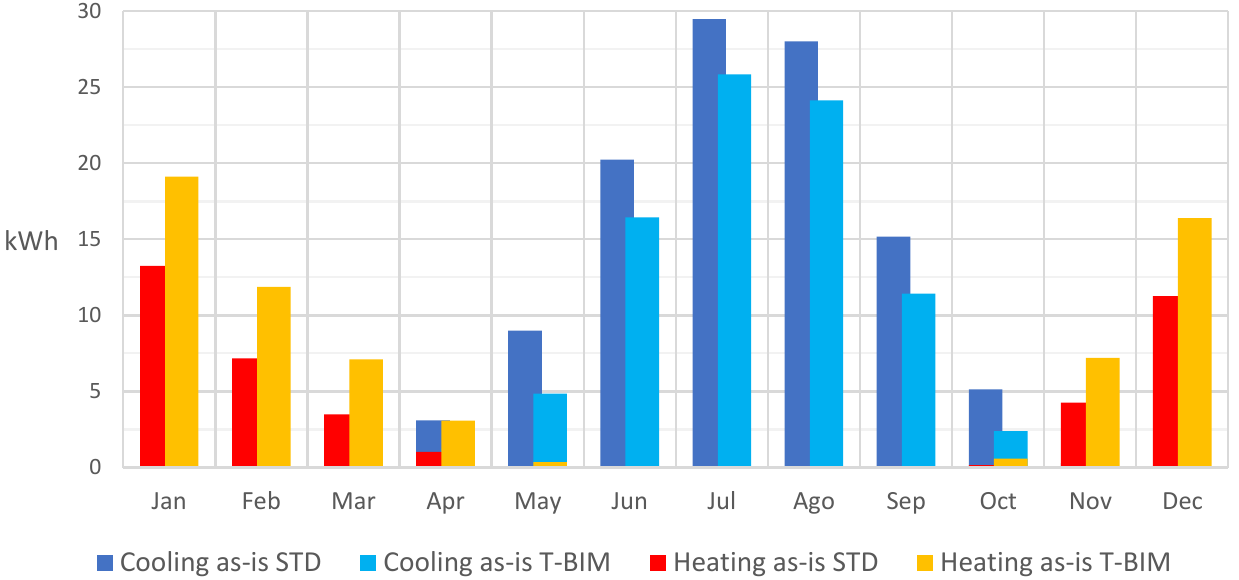
Figure 13. Monthly demand for heating and cooling of the models, as-is STD and as-is T-BIM, in a TMY 2007 – 2021.